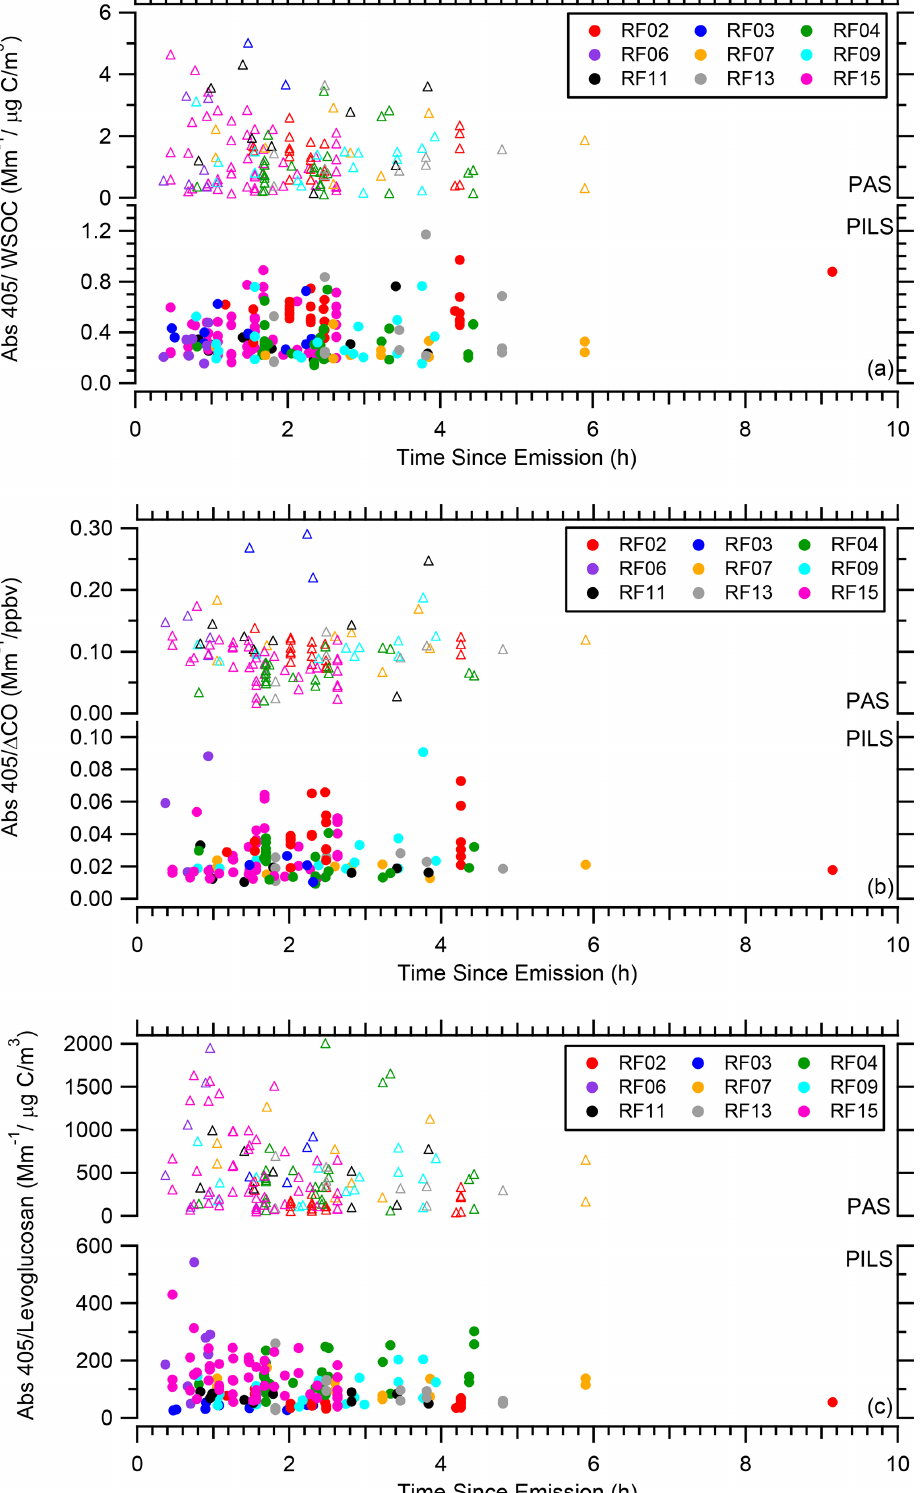
Atmos. Chem. Phys., 22, 13389–13406, 2022